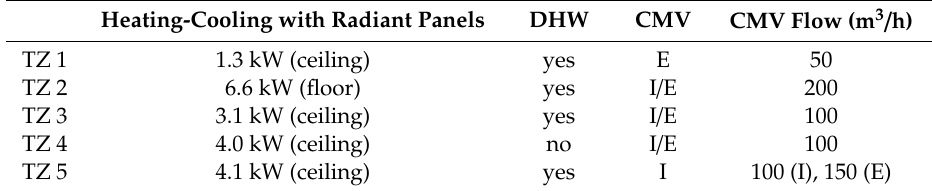
Table 3. Plants serving heated thermal zones (TZ) and location of radiant panels (floor / ceiling); CMV: I = immission, E =